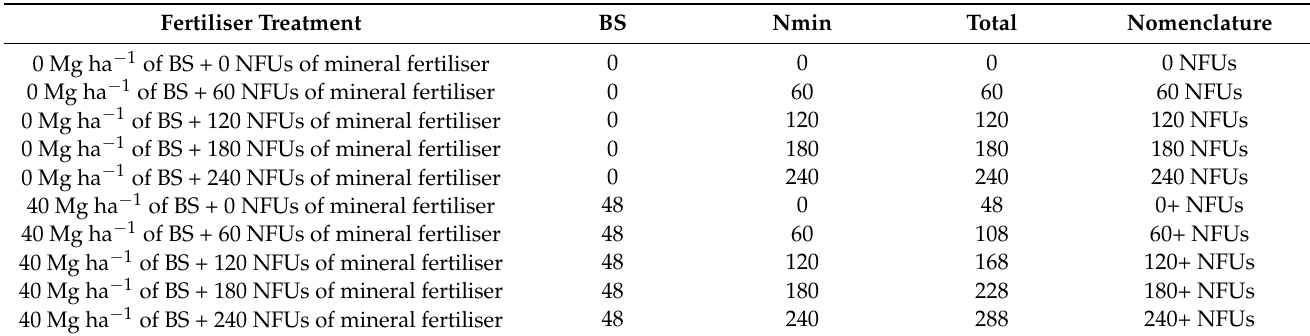
Table 2. Nitrogen fertiliser units (NFUs) contributed to the crop in the sampling year by biosolid (BS), mineral fertiliser (Nmin), and total (sum of BS and